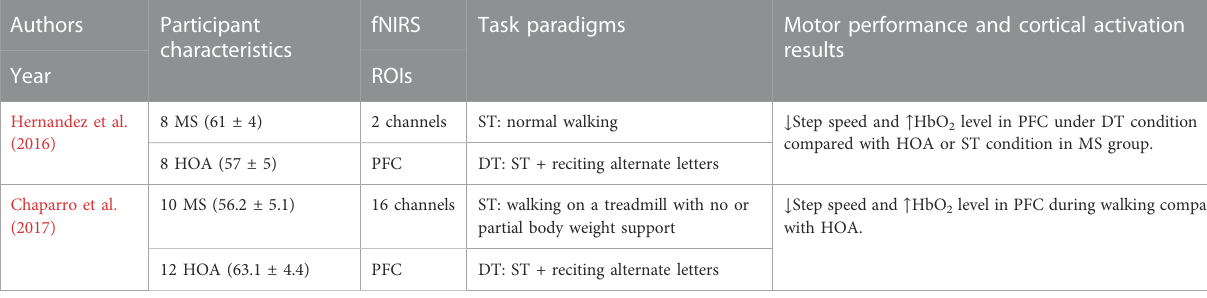
TABLE 3 Summary of motor performance and cortical activation outcomes in studies of MS patients. Authors